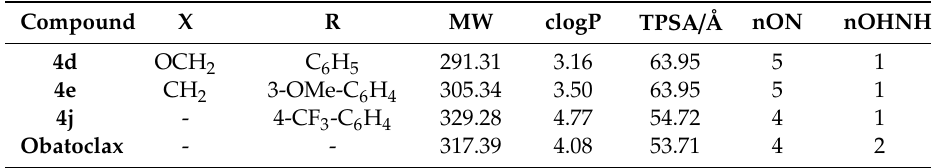
Table 3. Analysis of physicochemical properties of hit compounds exhibiting Bcl-2 inhibitory activity (calculated by using software available at